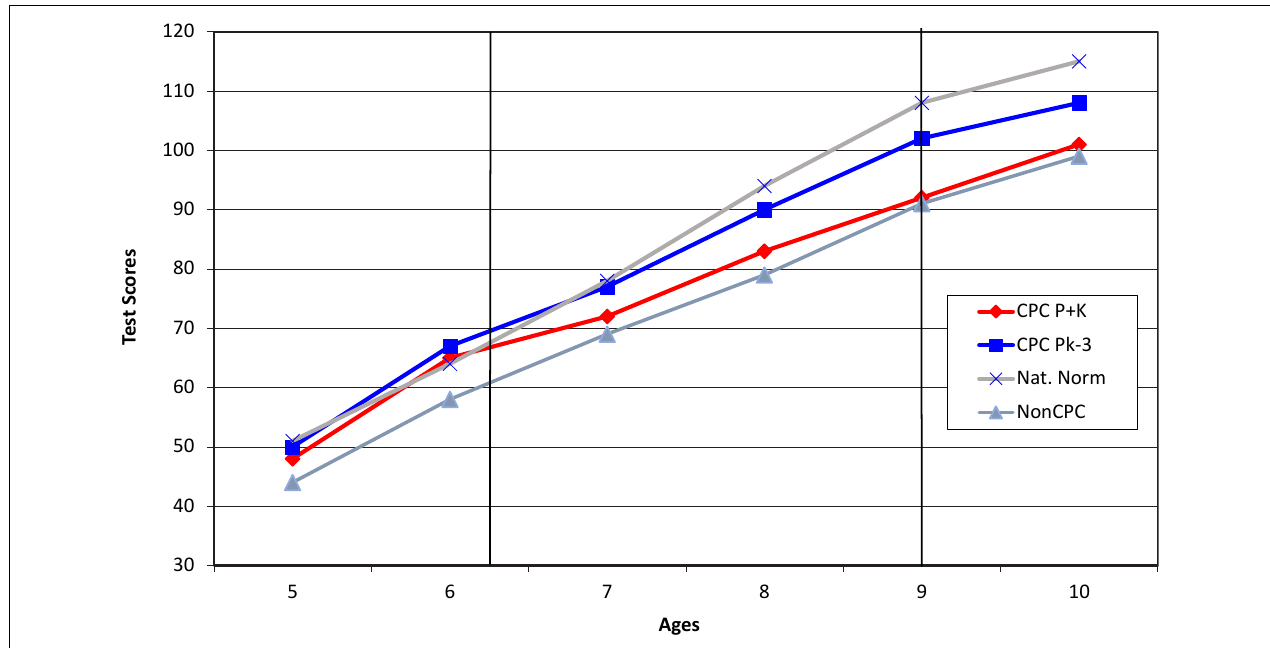
FIGURE 4 | Reading test scores for participants in the Child Parent Center program by length of participation at ages 5–10. Reading scores from Iowa Test of Basic Skills for CPC preschool plus extended intervention versus CPC preschool participants only and national